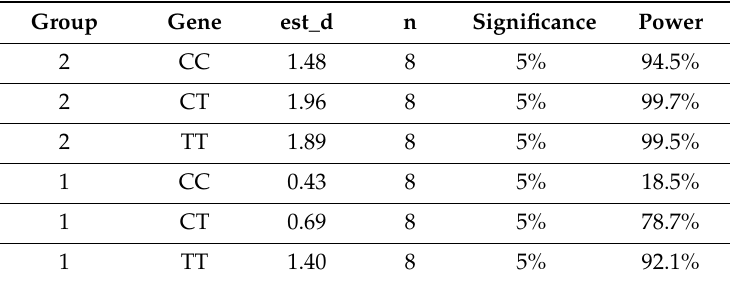
Table 1. Size E ff ect.